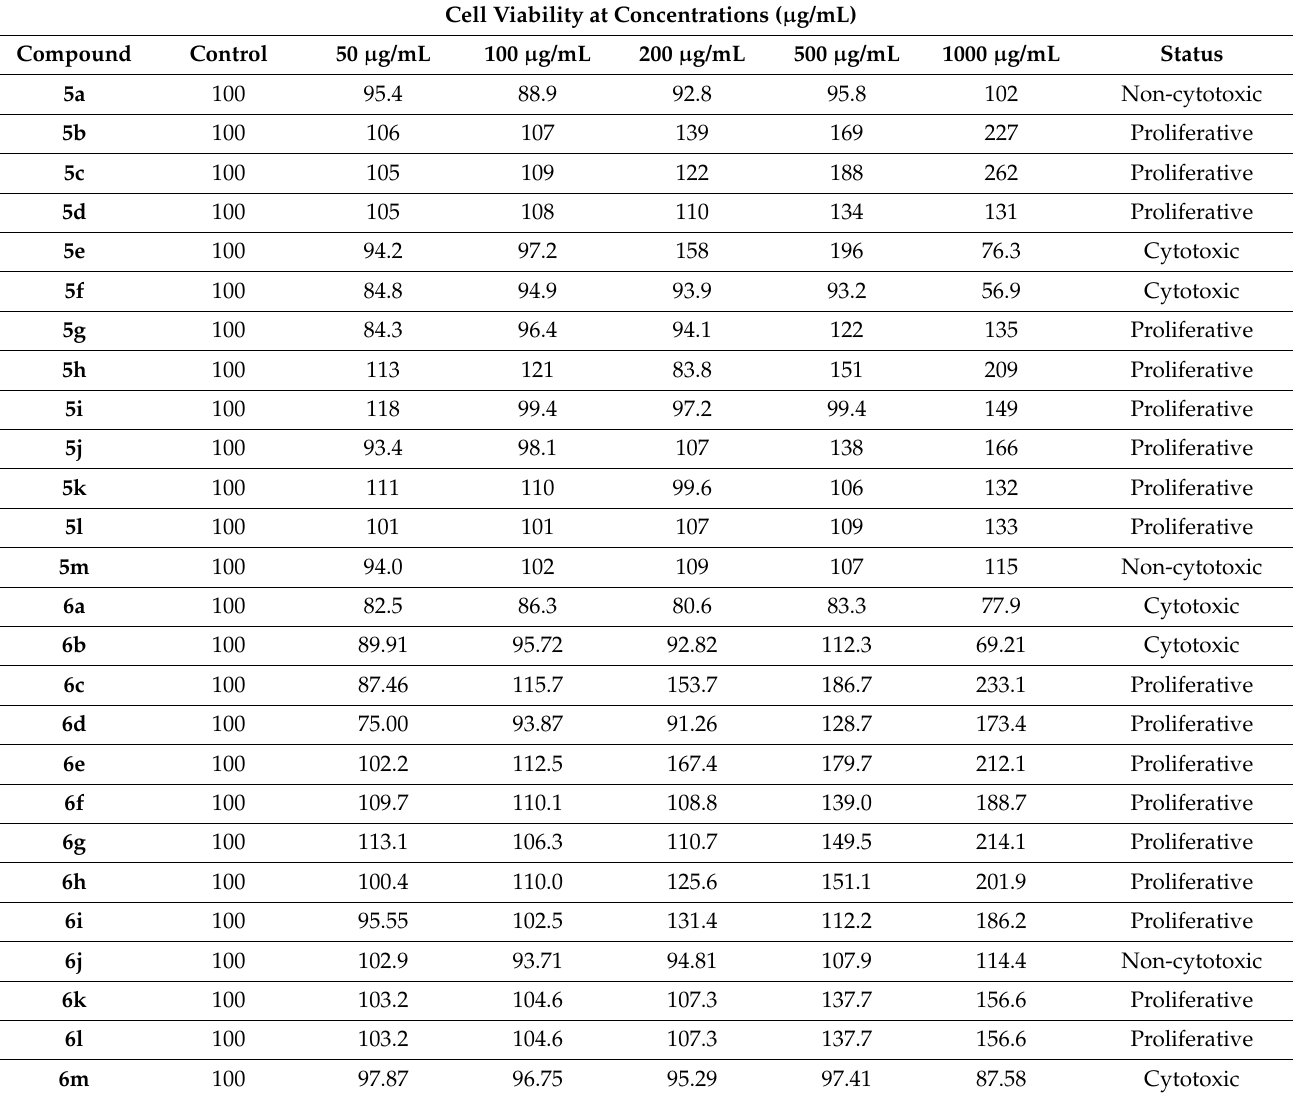
Table 4. Cytotoxicity results of the newly synthesized